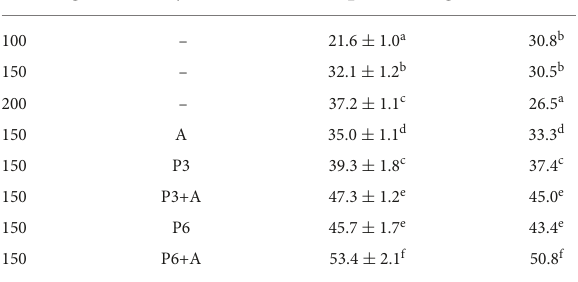
TABLE 1 Carbohydrates release expressed as glucose (g/L) and Glucose Yield (GY, %) in wasted bread homogenates obtained without enzyme treatment (incubation 1 h at 4 ◦ C), after pepsin treatment at 37 ◦ C for 3 or 6 h (P3 or P6, respectively) (3 mg/g of bread, pH solution of 2.5), α -amylase treatment at 37 ◦ C for 3 h (A) (5 mg/g of bread, solution pH of 6.9), or after sequential treatment with both the enzymes (P +